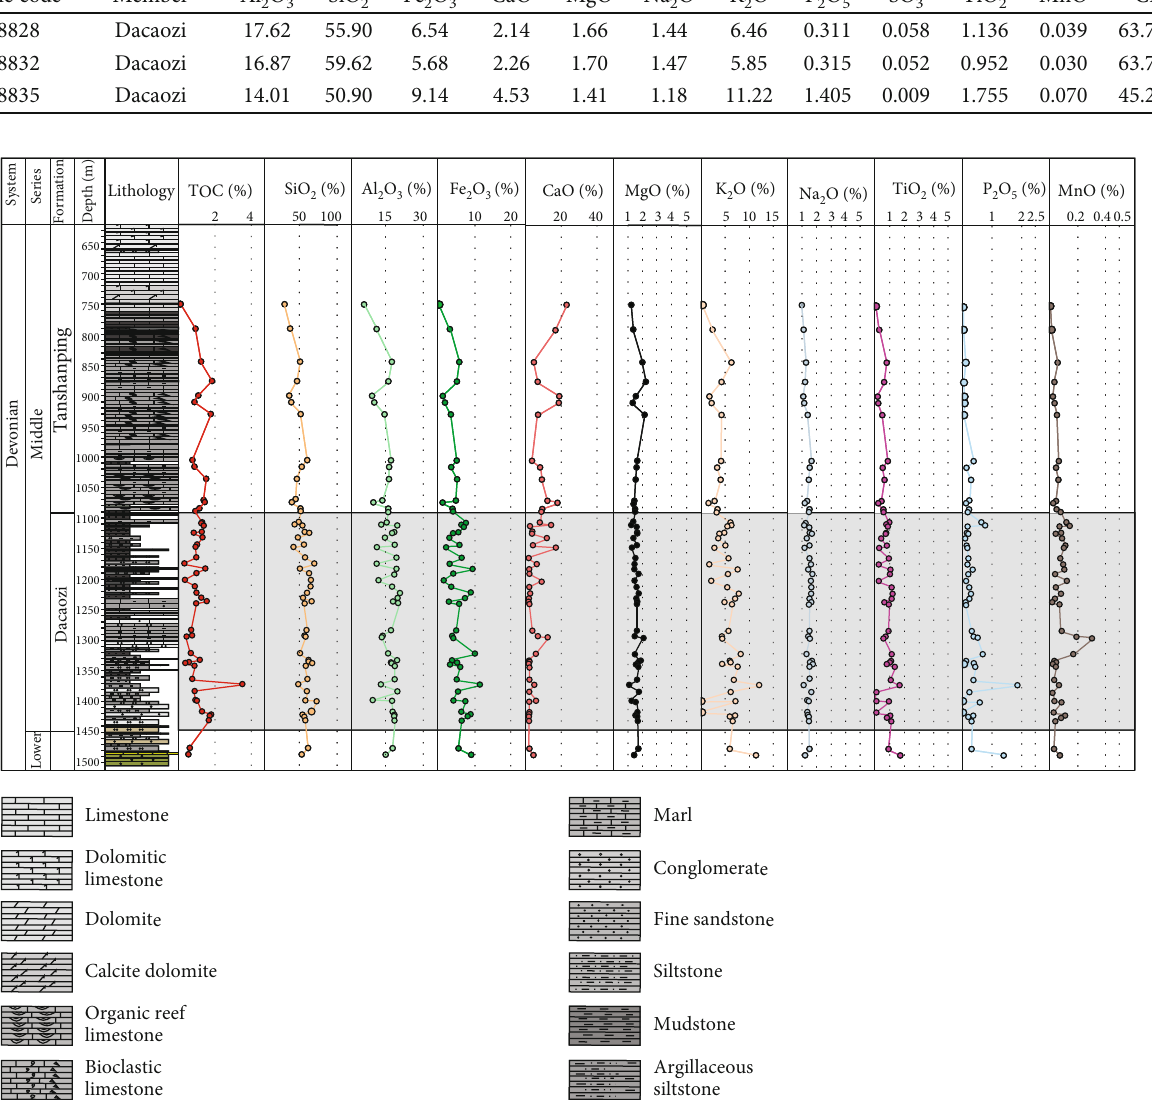
Figure 3: Main element and TOC content of YND-1 well in the Tanshanping Formation and Dacaozi Formation in the Ninglang-Yanyuan area (see Figure 2 for the well